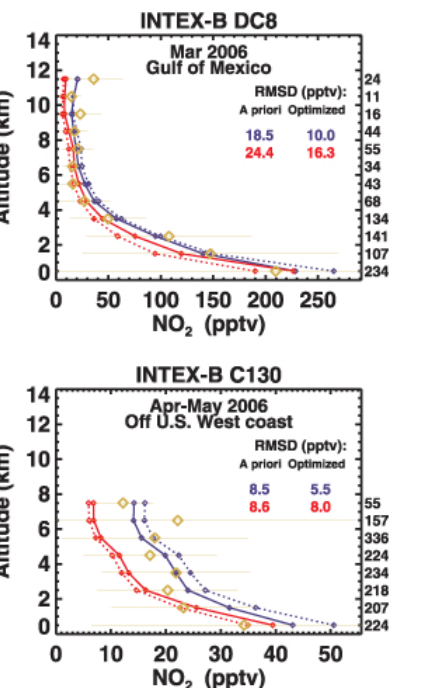
Fig. 12. Same as Fig. 11 but for oceanic